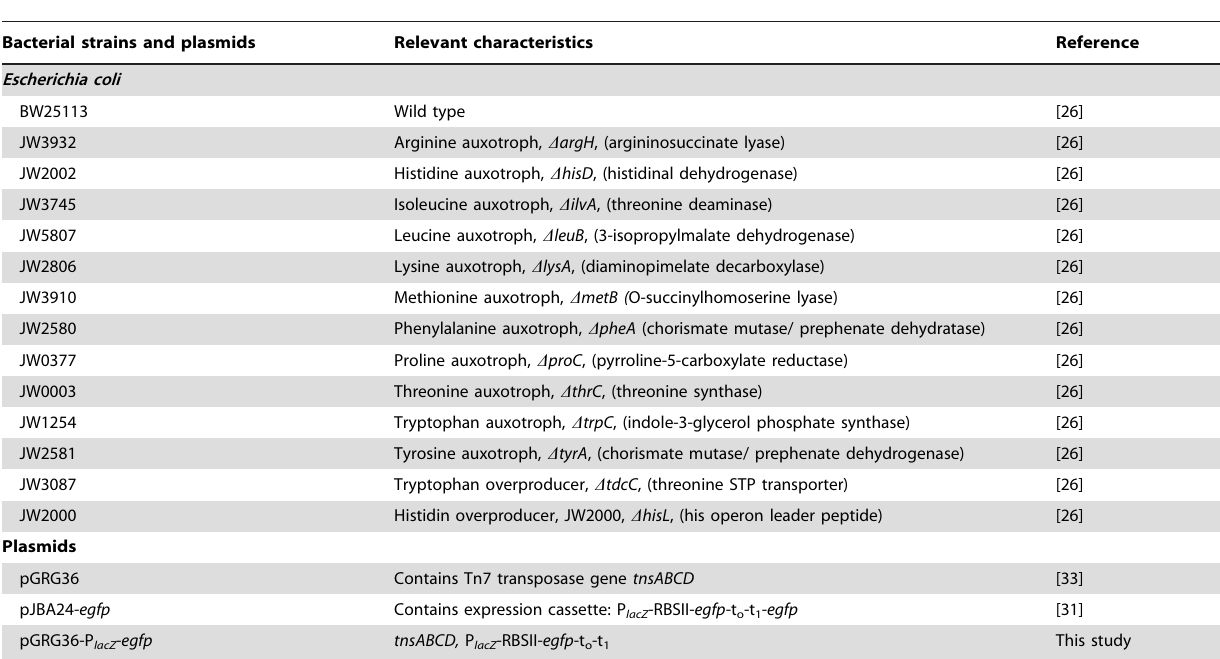
Bacterial strains and plasmids Relevant